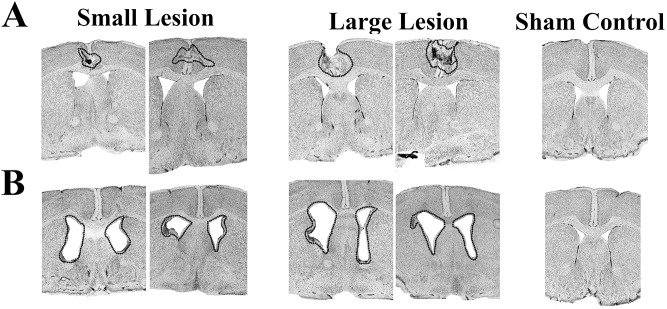
Histological verification and lesion size determination.Representative coronal sections of bilateral (A) aCC and (B) DMS lesions. The left, middle and right pictures represent small, big and sham control lesions, respectively. All lesions were restricted to the region of interest. The bilateral lesions are encircled by a dotted line.